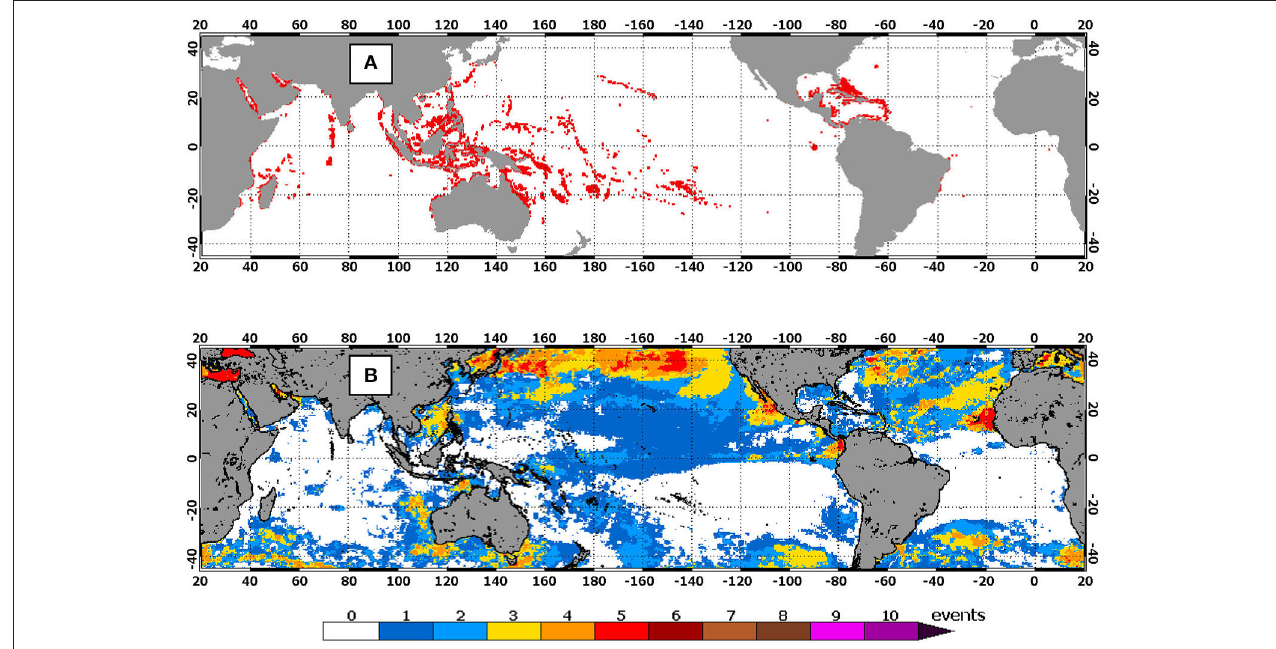
FIGURE 4 | (A) Map of tropical coral reef locations; (B) Numbers of observed bleaching events identified by CRW’s 50km satellite monitoring during the comparison time period of August 1, 2011–December 27,